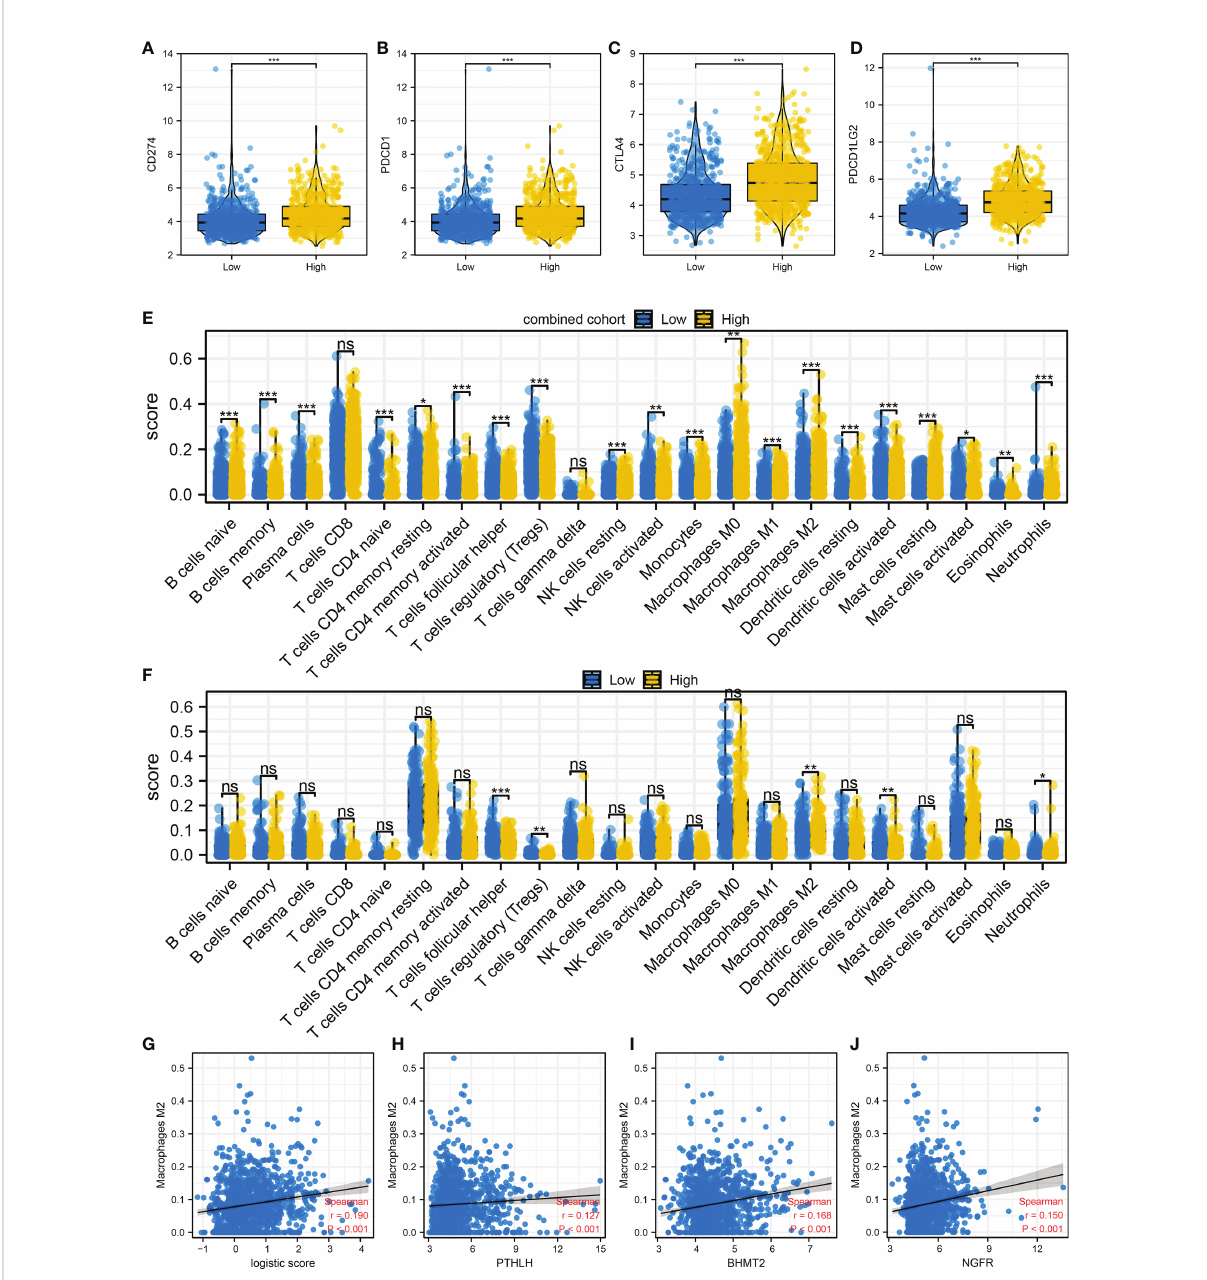
FIGURE 6 Immune microenvironment difference in patients with a high and those with a low logistics score (A – D) Hub immune checkpoints in patients with a high and those with a low logistics score. (E) The level of quanti fi ed immune cells in patients with a high and those with a low logistics score (combined cohort). (F) The level of quanti fi ed immune cells in patients with a high and those with a low logistics score (IMvigor210 cohort). (G) Correlation between logistics score and M2 macrophages. (H – J) Correlation between PTHLH, BHMT2, NGFR, and M2 macrophages. *P < 0.05, **P < 0.01, ***P < 0.001. ns: P >